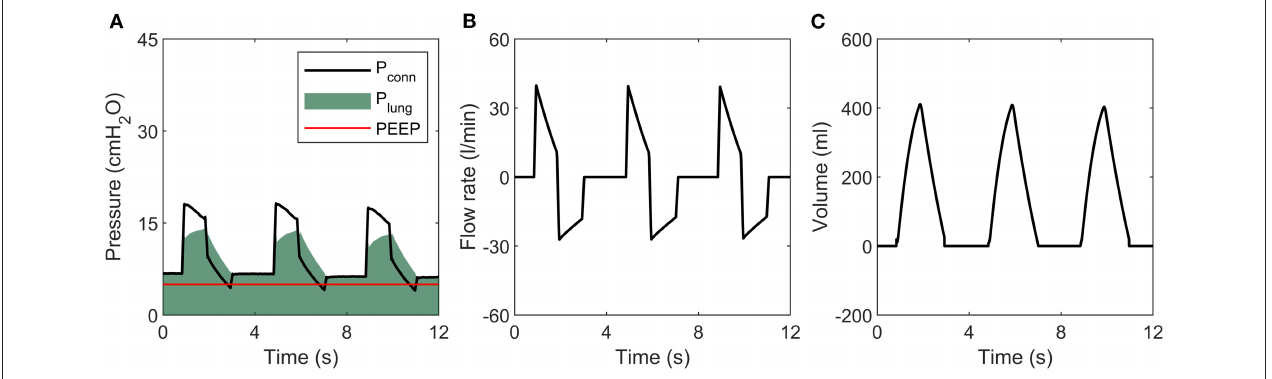
FIGURE 3 | Sample tracing during ventilation of an R20/C20 lung. (A) Pressure, (B) Flow rate, (C)